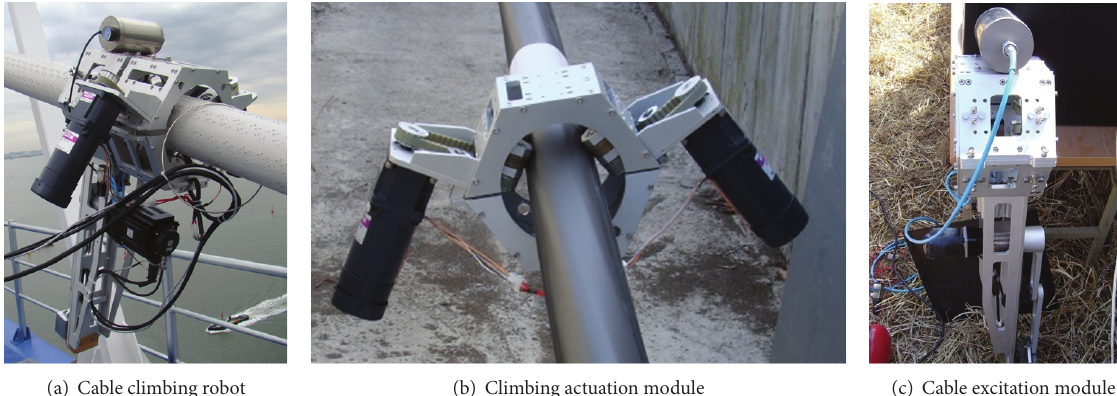
Figure 18: Cable climbing robot for stay cable